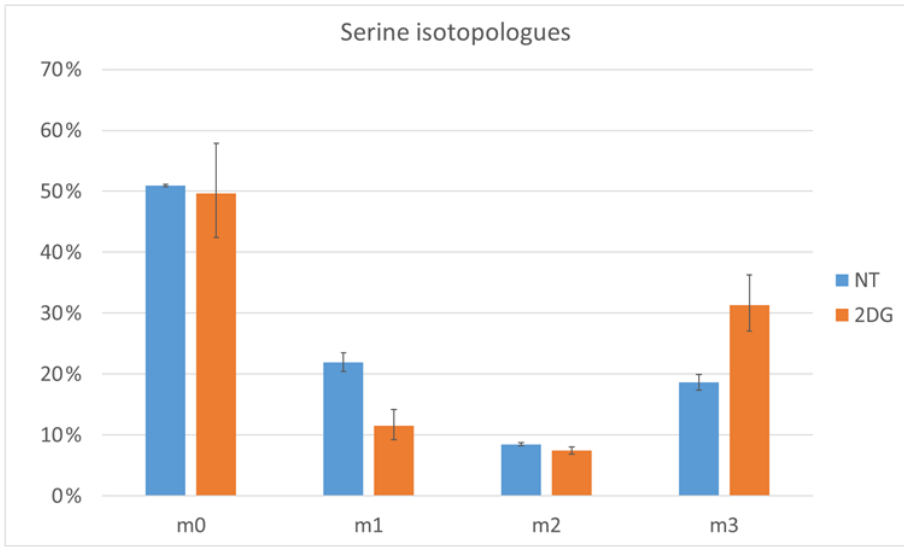
Figure 4. Serine-labeling pattern in non-treated (NT) and 2DG treated cells (2DG). The error bars mark the 95% confidence